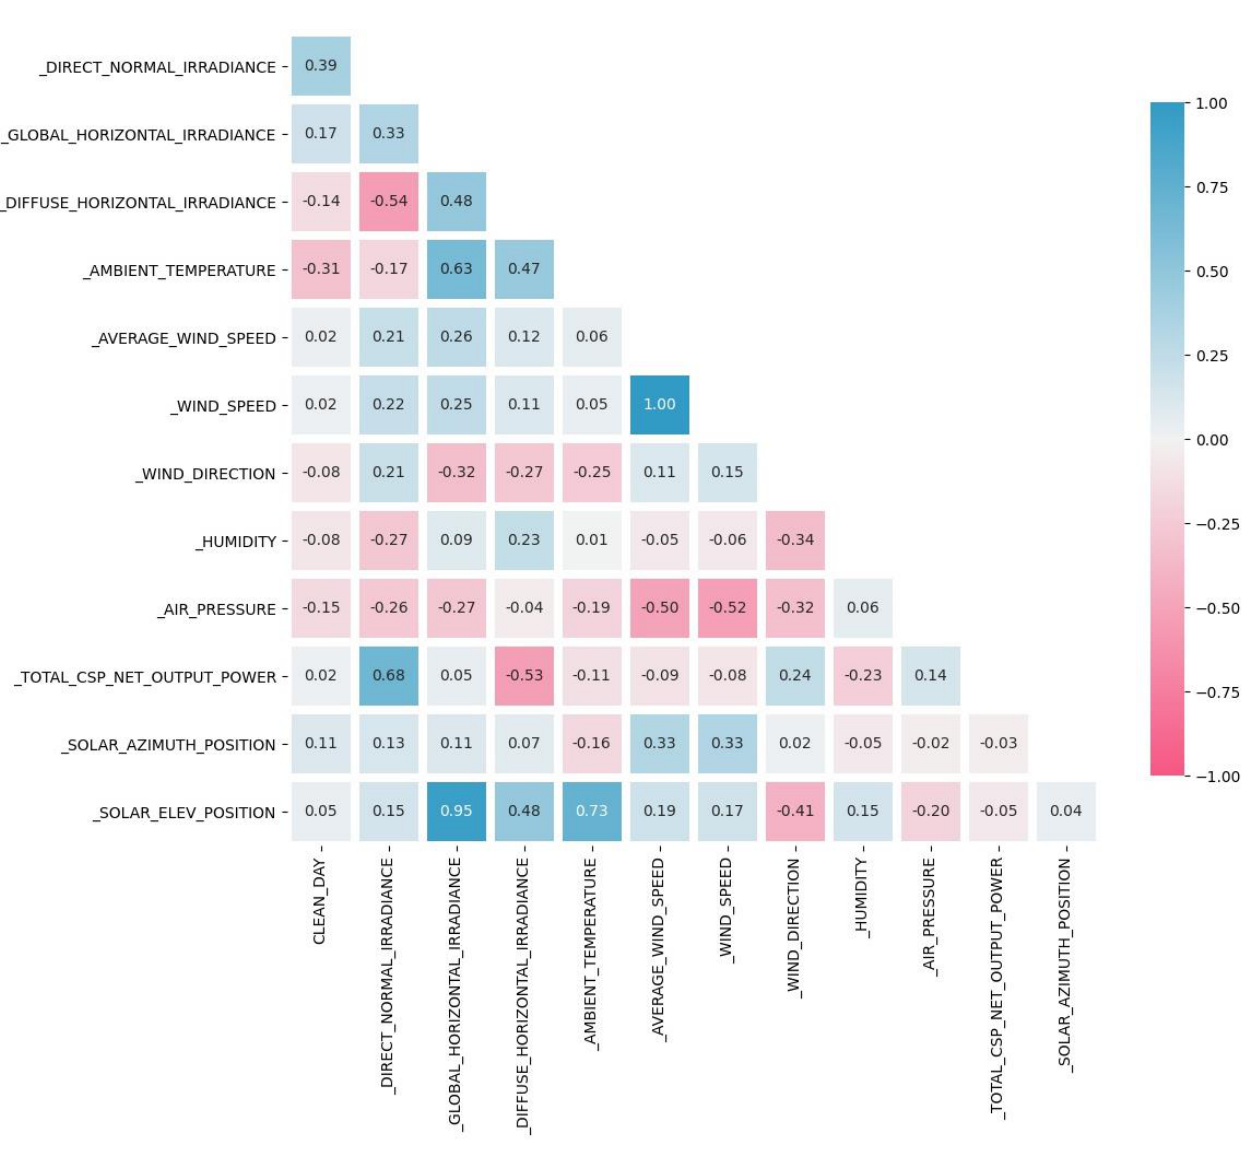
Figure 5. Correlation matrix of variables of the original dataset without outliers (Pearson correlation coefficient).